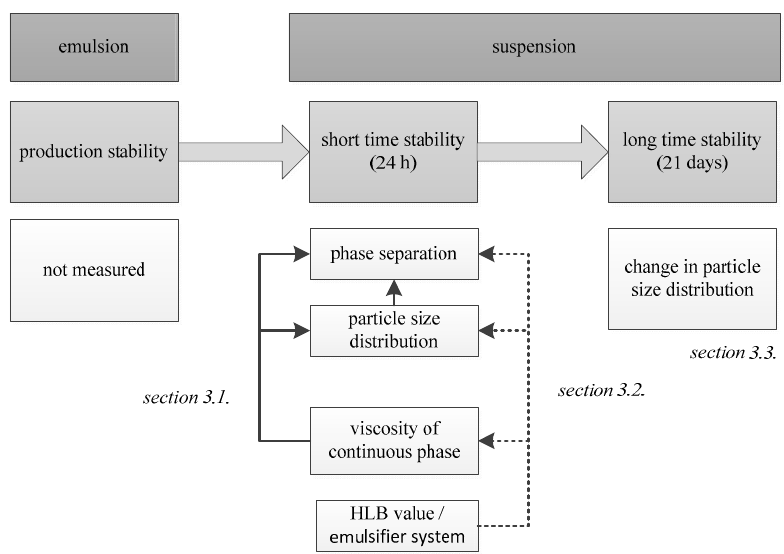
Figure 1. Processes decreasing the short- and long-term stabilities of melt emulsions.